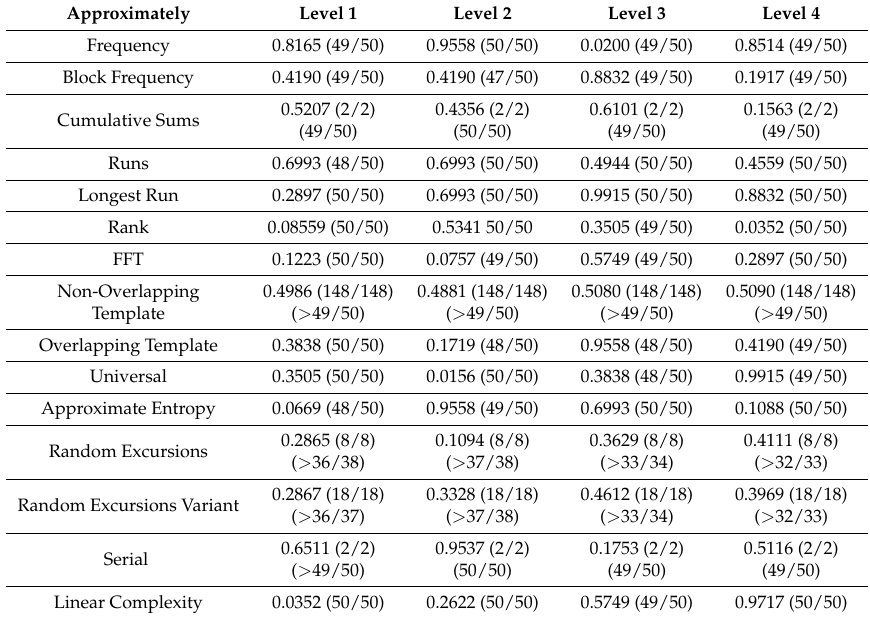
Table 3. NIST results.